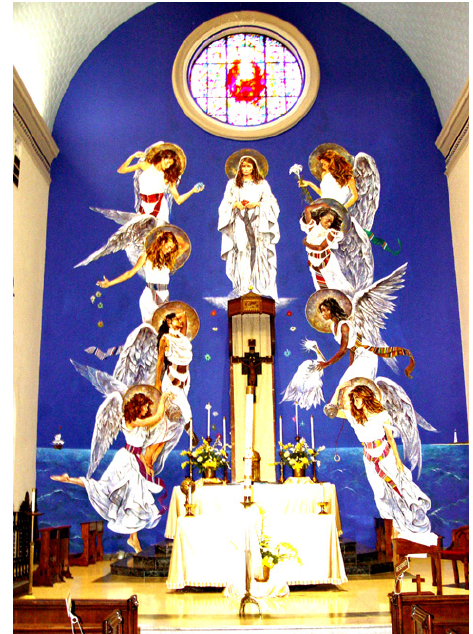
Figure 11. Mural of “Dance of Holy Innocence”, located in Our Lady of the Sea Parish, New Orleans, Louisiana; Image from the website http://www.neworleanschurches.com/StarofSea/star.htm (accessed on 29 November 2021); Image credit John and Kathleen DeMajo. November 2021.